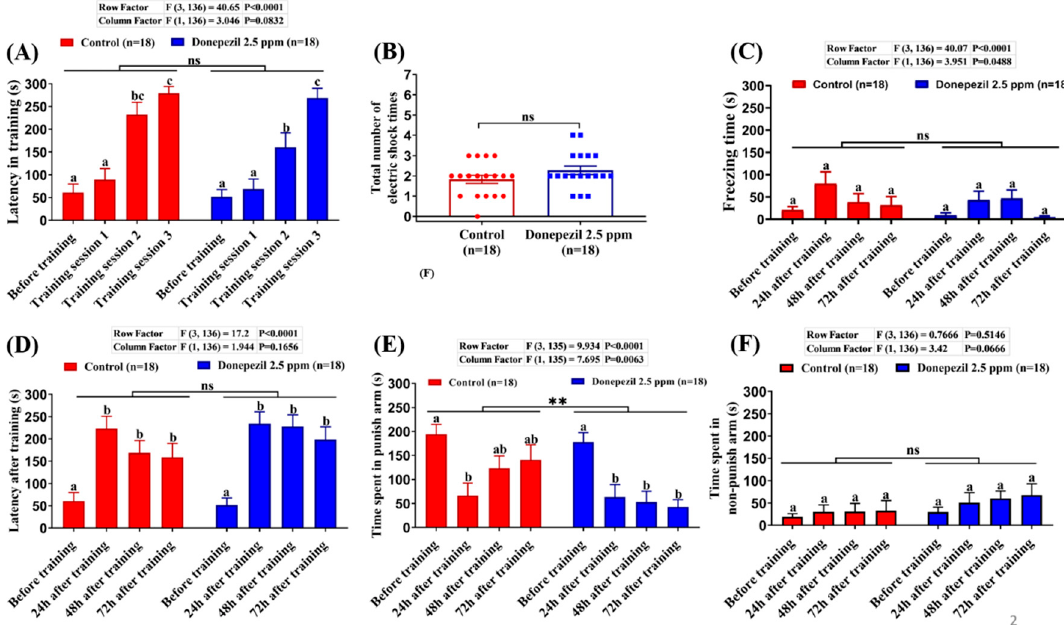
Figure 1. T-maze conditioning passive avoidance to test short-term memory of fish after 21 days exposure to 2.5 ppm of donepezil: ( A ) the latency of control and donepezil-exposed fish swimming into the punish chamber for each training session; ( B ) the total number of electric shocks given for successful training between control and donepezil-exposed fish; ( C ) the freezing time of control and donepezil-exposed fish at di ff erent time points before and after training; ( D ) the memory retention of control and donepezil-exposed fish at di ff erent time points before and after training; ( E ) the time spent in punish arm of control and donepezil-exposed fish at di ff erent time points before and after training; ( F ) the time spent in the non-punish area of control and donepezil-exposed fish at di ff erent time points before and after training. The data are expressed as the mean ± standard error of the mean (SEM) values. Di ff erent letters (a, b, c) on the error bars represent the significant di ff erences ( p < 0.05); A and C–F were analyzed by two-way ANOVA with Tukey-HSD (Honestly Significant Di ff erence) post hoc test; B was analyzed by unpaired t-test; n = 18, ** p < 0.01.